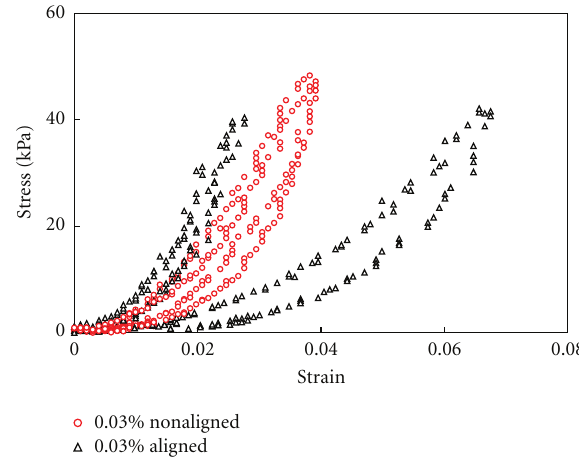
Figure 7: Representative stress-strain response of the aligned and non-aligned collagen sca ff olds crosslinked with 0.03% GP. Equi- biaxial tensile test reveals obvious anisotropic mechanical behavior in the aligned collagen sca ff